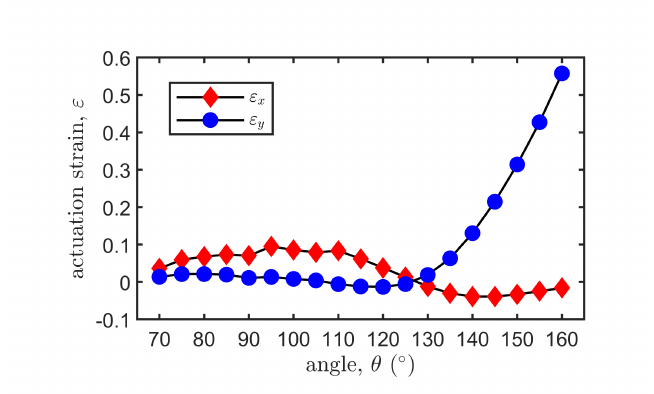
Figure 5. Voltage-induced axial strains ε x and ε y with different θ under λ 1 = 4.0, λ 2 = 2.5.